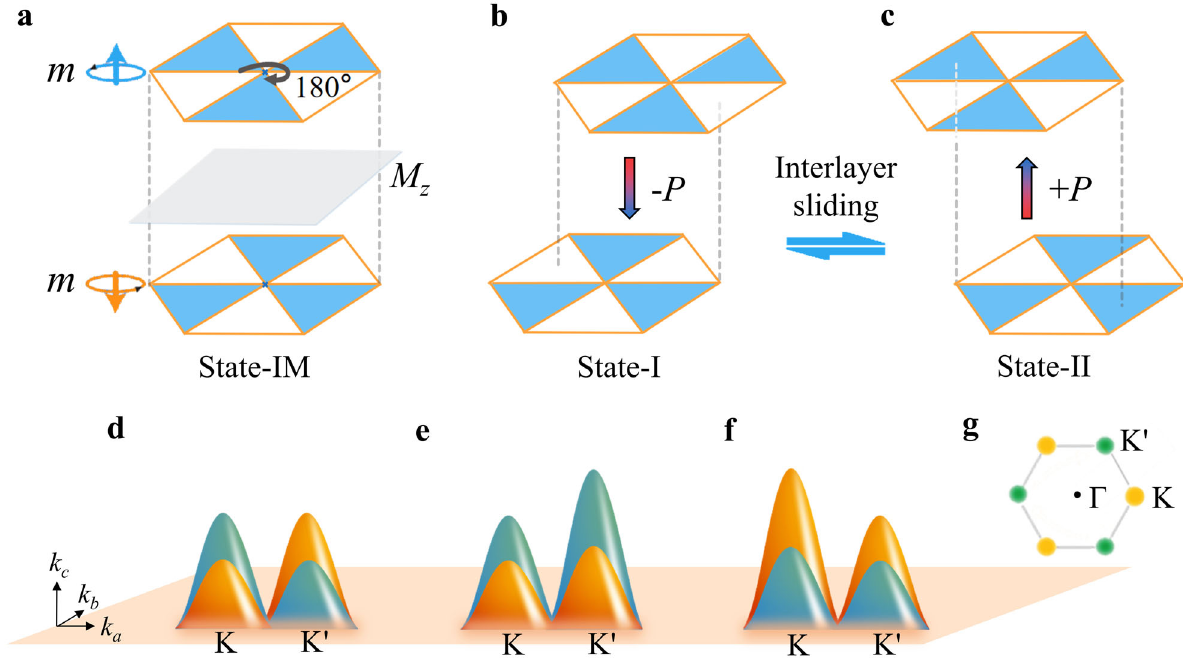
Fig. 1 Design principle based on van der Waals interaction. Diagrams of a state-IM, b state-I, and c state-II. Left circles in a indicate the magnetization orientations. Schematic diagrams of bands around the K and K ′ valleys in d state-IM, e state-I, and f state-II. Blue and yellow cones in d – f corresponds to spin-down bands from the upper and spin-up bands from the lower layers, respectively. g 2D Brillouin zone for bilayer trigonal